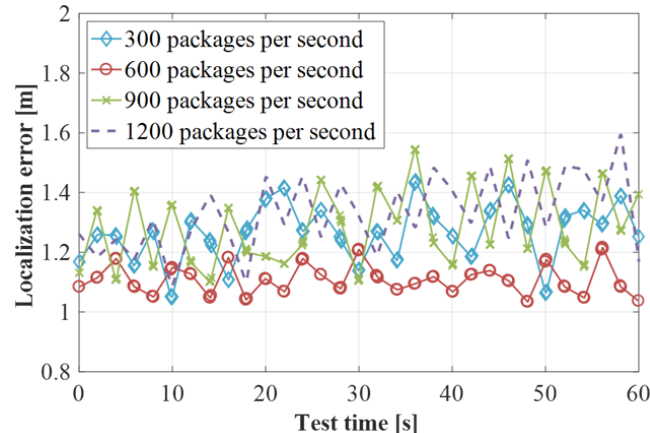
Figure 8. Change the impact of the packet rate on the positioning